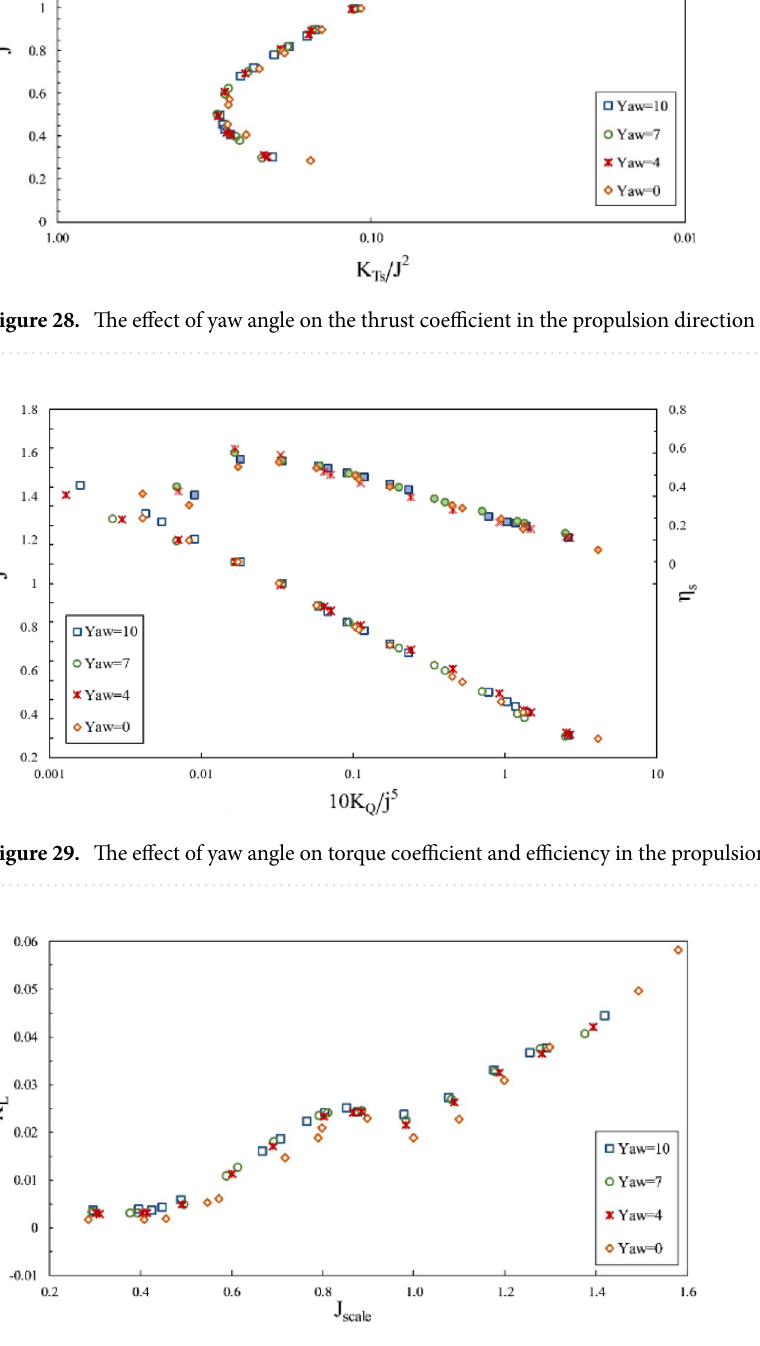
Figure 30. The effect of yaw angle on the lift coefficient in the propeller direction ( I = 0.6